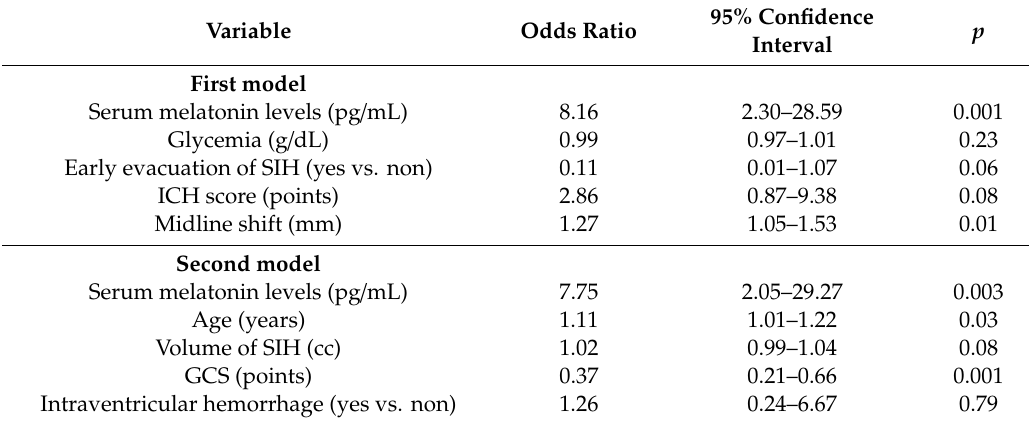
Table 2. Logistic regression analysis to predict 30-day